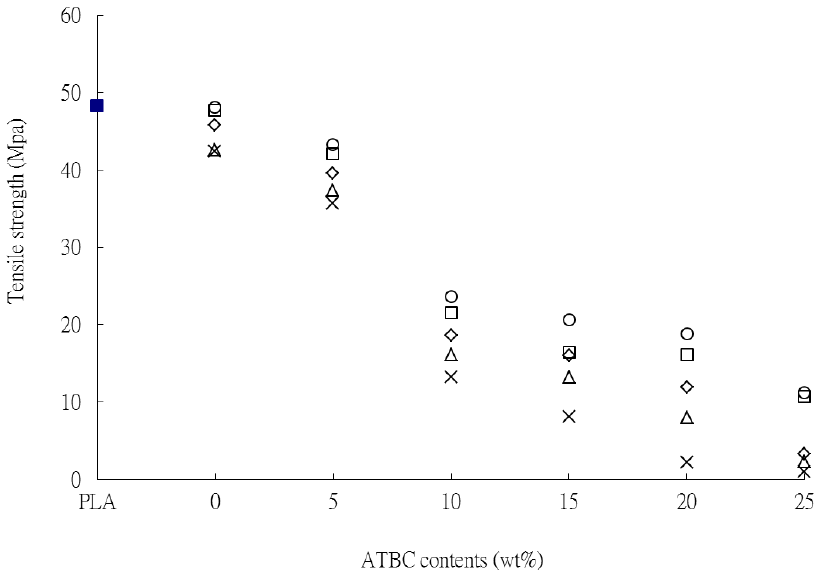
tapioca MDI ; ( ◇ ) PLA 80 20 0.5 tapioca MDI . 50 50 0.5